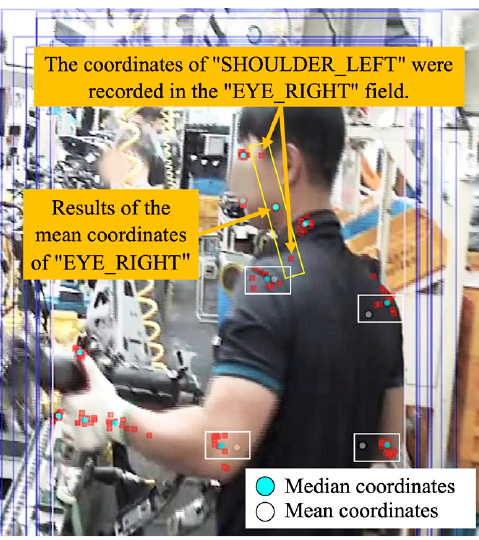
Figure 9. An error of the recommended value.